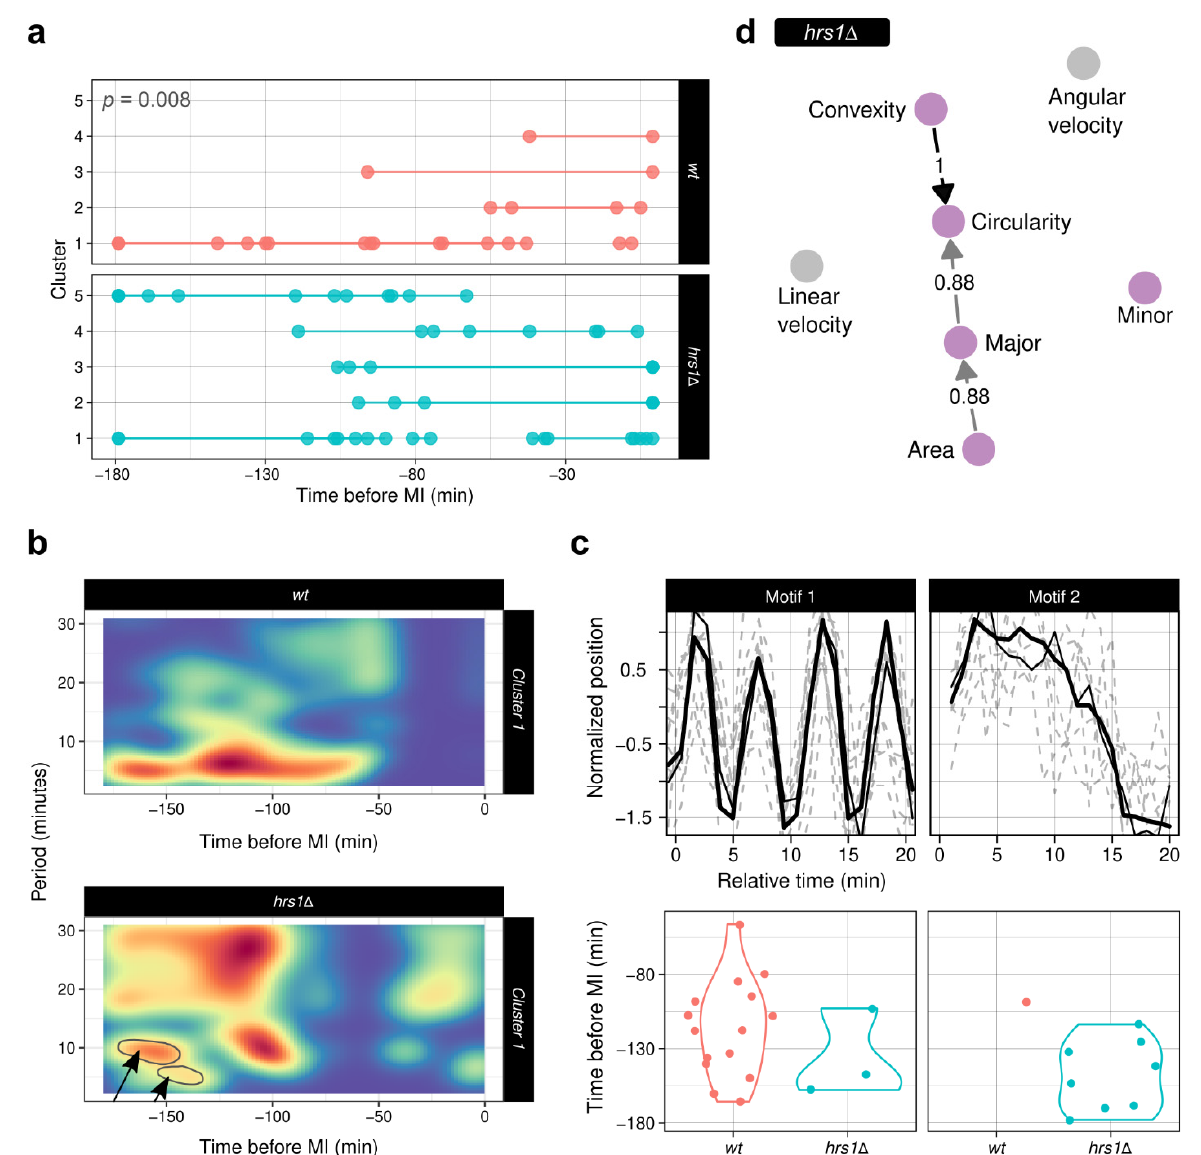
Figure 6. ChroMo analysis of CM in the hrs1 ∆ strain highlights an oscillatory movement. ( a ) Segment-plots of the unsupervised segmentation after segclust2d ’s algorithm with Lavielle’s criterion selection, for linear and angular velocities calculated from rotated 2D trajectories. Top left, reported p -value for the ANOVA after LR between wt and hrs1 ∆ , comparing the interaction between cluster type and duration, and the intercept-only model. ( b ) Heatmap-spectrograms for cluster 1, across wt and the mutant. Black arrows and outlines inside the plot indicate the conservation of oscillatory behaviour around the 10 min period, early in meiotic prophase. ( c ) Top-2 discovered motifs, using a time-window of 20 min, are shown. In each motif plot, a maximum of 100-top matches is aligned. Below, a violin-plot illustrates the time distribution of each motif for all groups being analysed. ( d ) DG for the causality relations found by VLTE algorithm with a maximum lag of 10 and a presence threshold of 80%. Pink nodes illustrate morphology variables; grey edges illustrate movement variables.